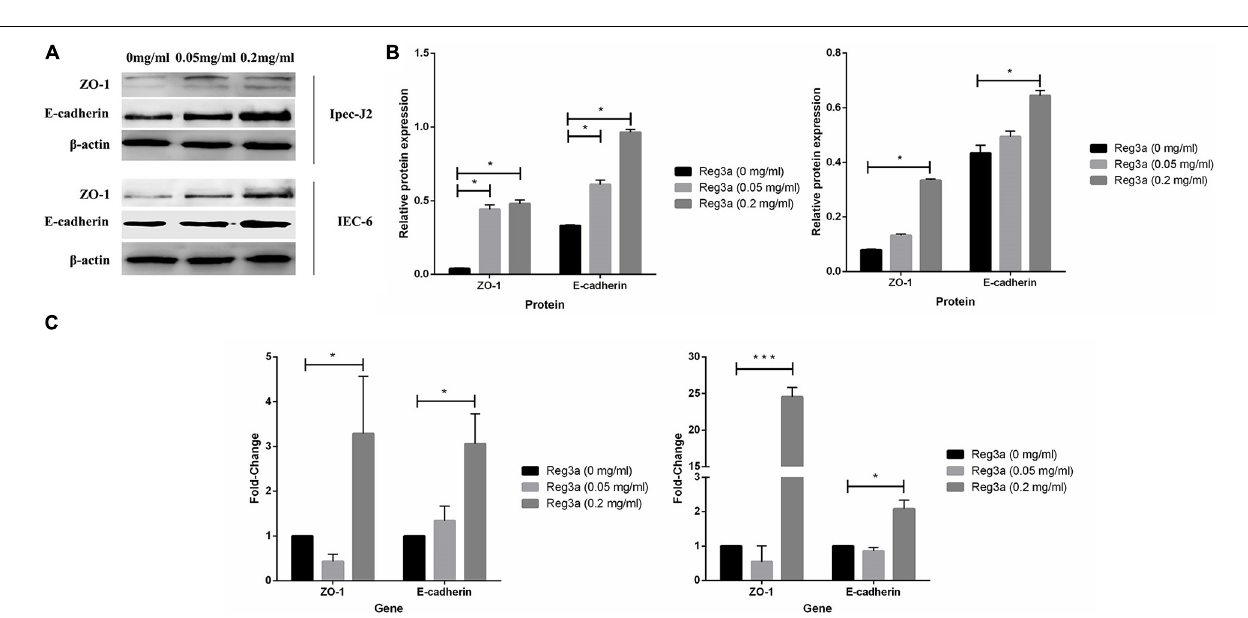
FIGURE 9 | Relative quantification of tight junction protein by Western Blot and qRT-PCR. The cells Ipec-j2 and IEC-6 were treated with the recombinant antimicrobial peptide Reg3a within 24 h. There was no antimicrobial peptide as control. Western blot data (A) were performed with bar plot by gray analysis (B) . For qRT-PCR assay (C) , relative quantification of tight junction proteins were calculated by 2 - (cid:77)(cid:77) Ct method. Error bars indicate standard deviations. * p < 0.05, ** p < 0.01, and *** p < 0.001 were compared by Student’s t -test to evaluate differences between every two groups.